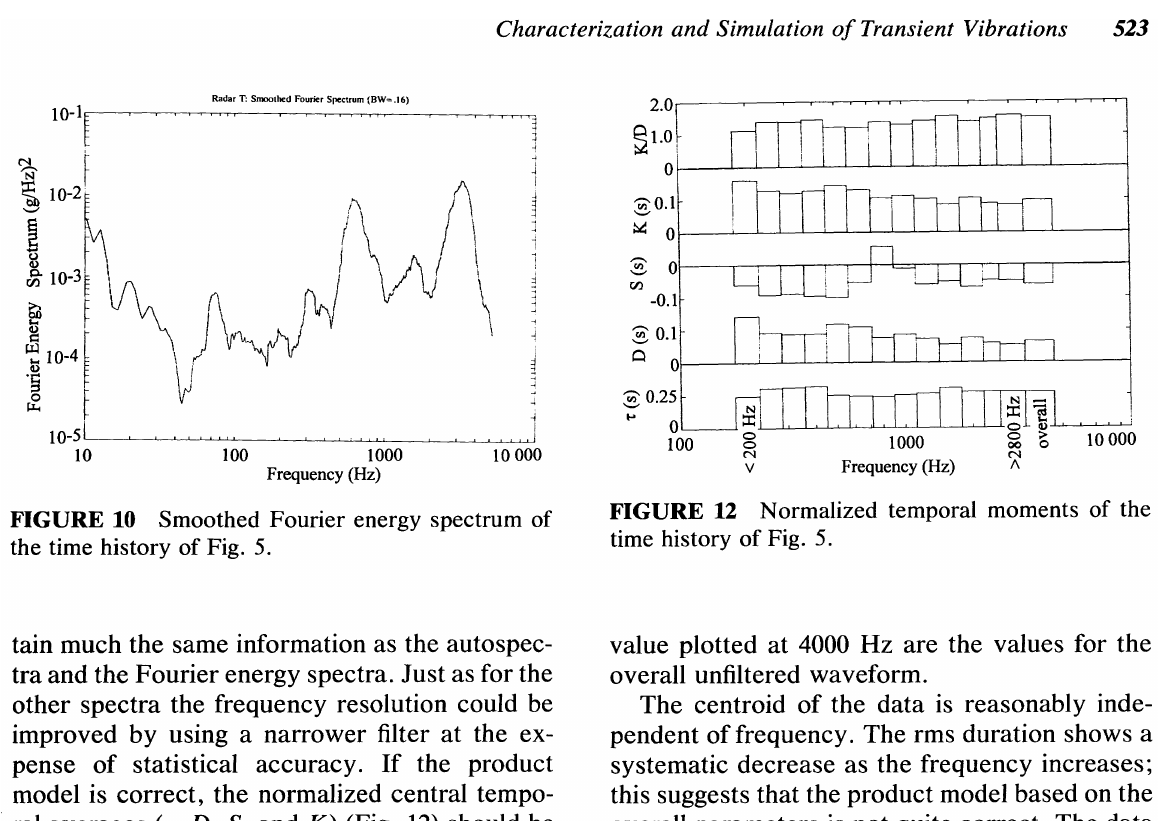
FIGURE 12 Normalized temporal moments of the time history of Fig.